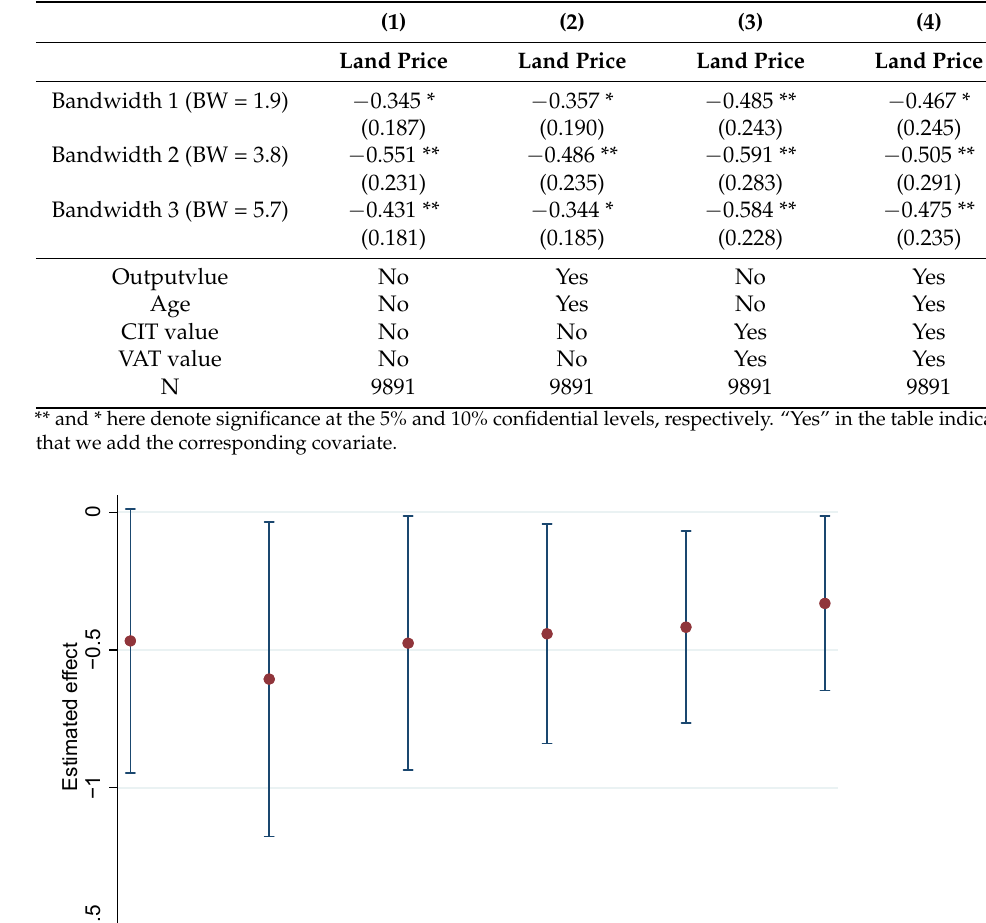
Table 2. Impact of the tax collection reform on land prices.